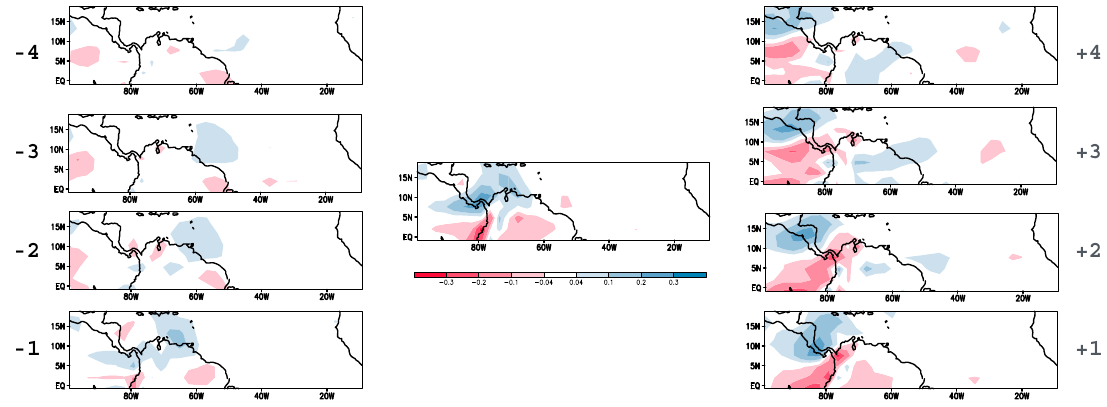
Figure 1. Significant lagged cross-correlation between precipitation anomalies in northern South America and smoothed relative vorticity anomalies for the JJAS season. The box in the middle panel shows the region where precipitation anomalies were